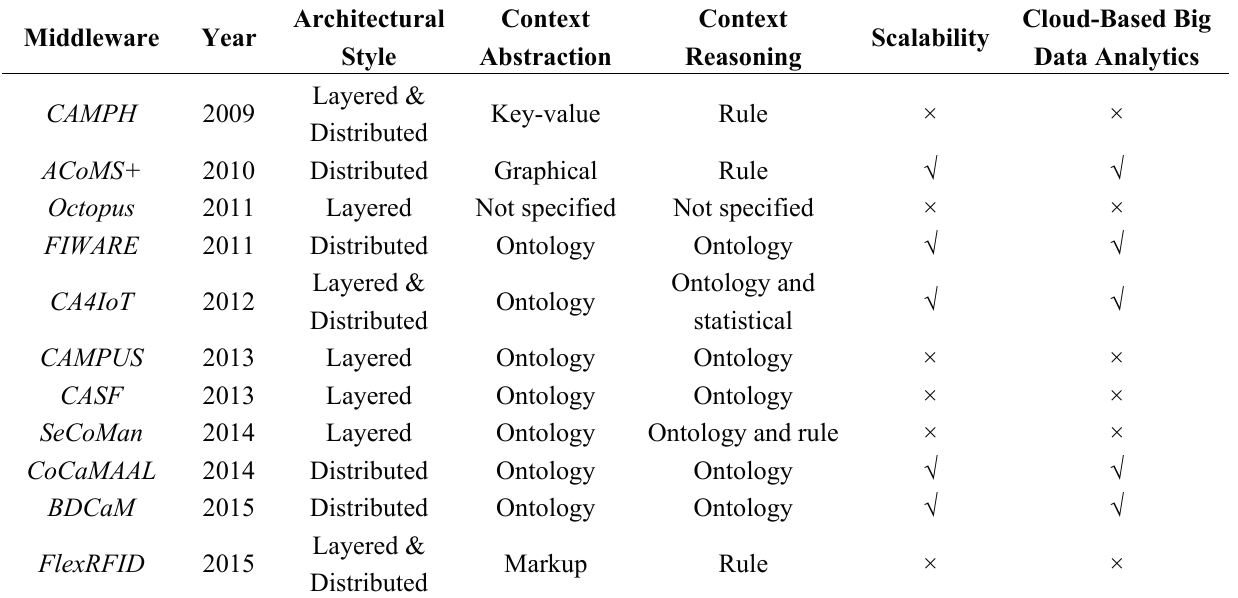
Table 4. Comparison of context aware middleware architectures (Part I).